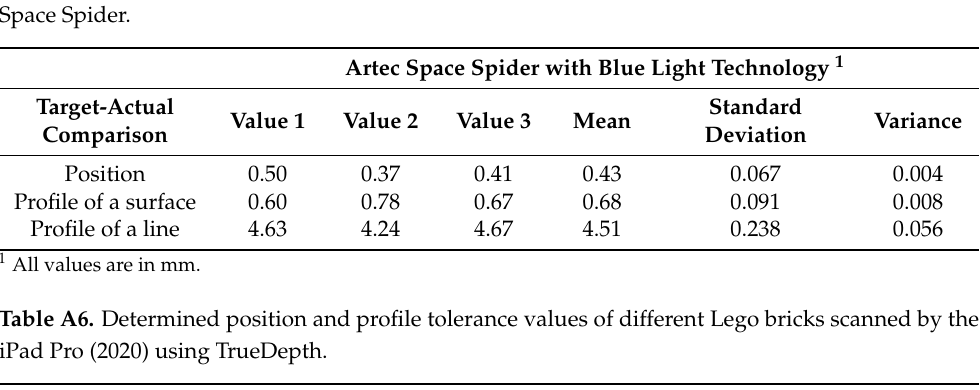
Table A5. Determined position and profile tolerance values of different Lego bricks scanned by Artec Space Spider.